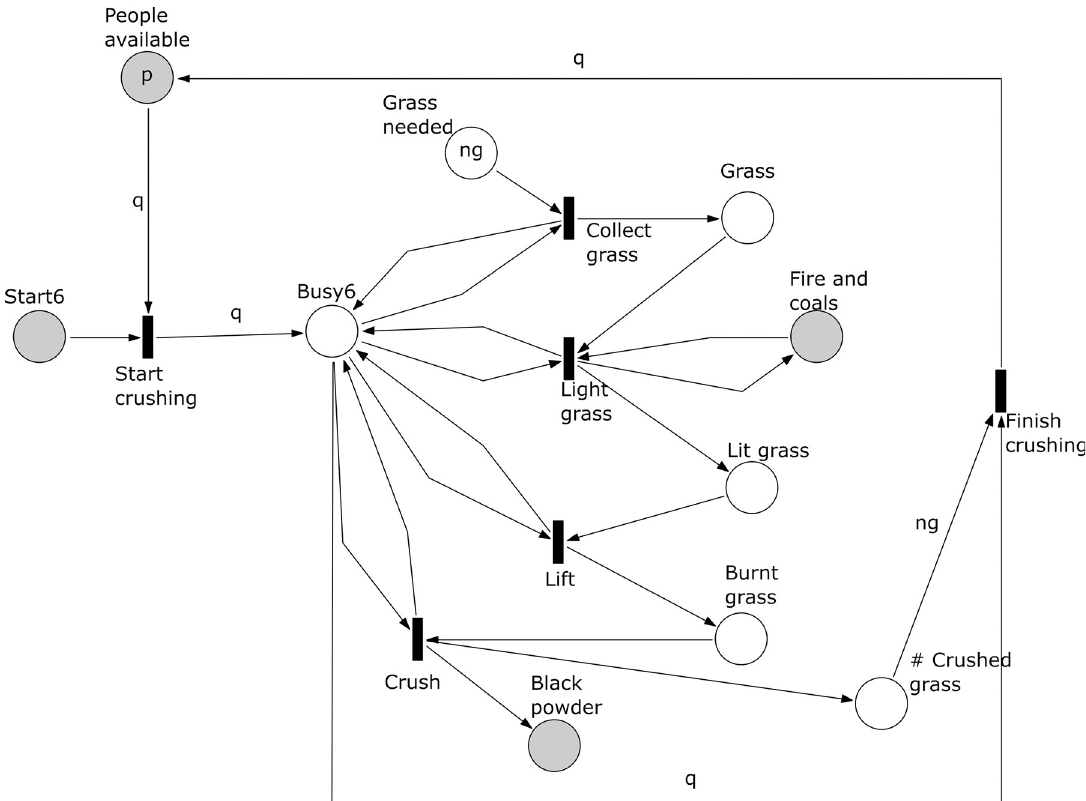
Fig 17. Subprocess 6 Burn and Crush Grass of the O . Schinzii model.